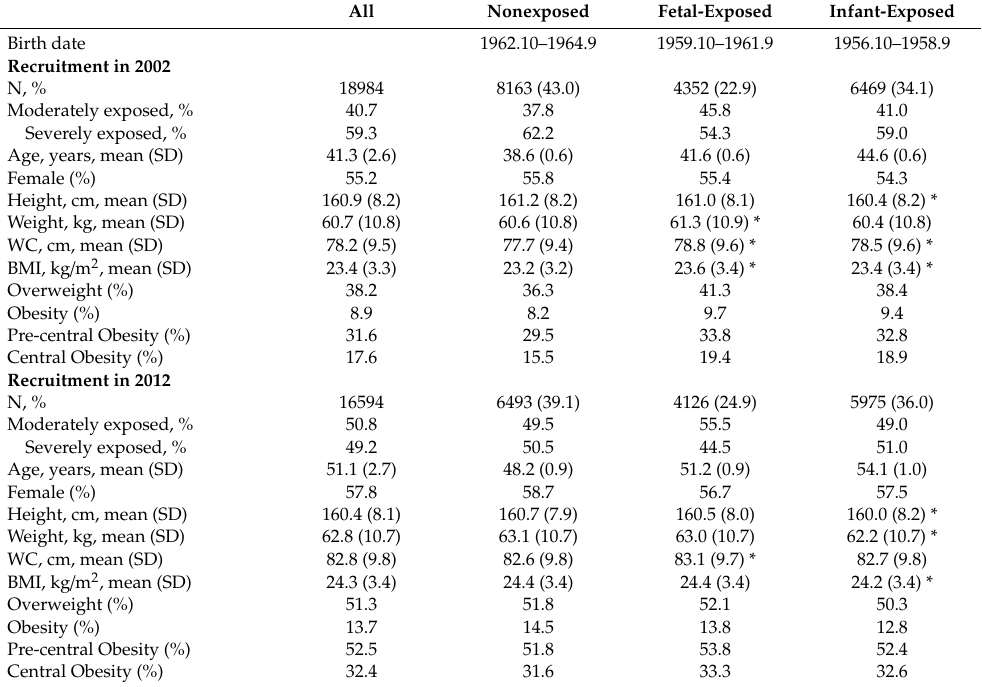
Table 1. Characteristics of study population according to Chinese famine exposure. All Nonexposed Fetal-Exposed